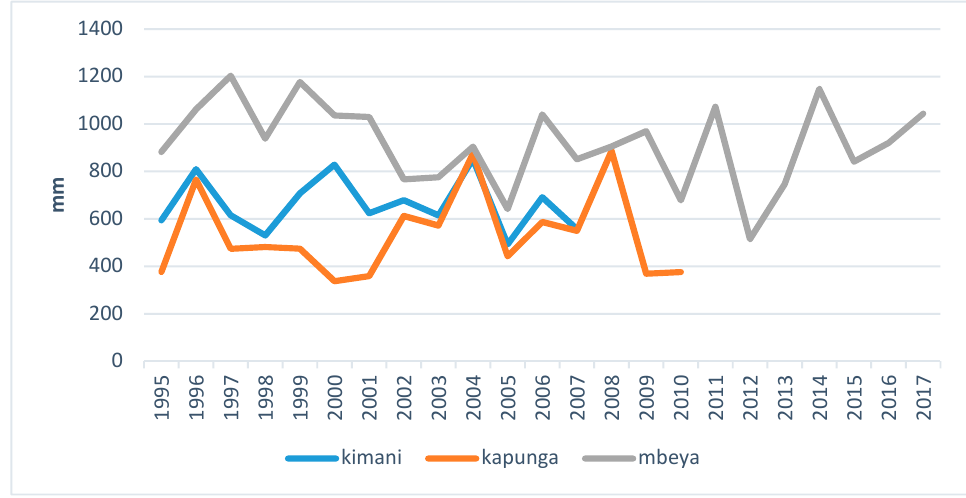
Figure 6. Rainfall trends in the sub-catchment (1995–2017) in mm.